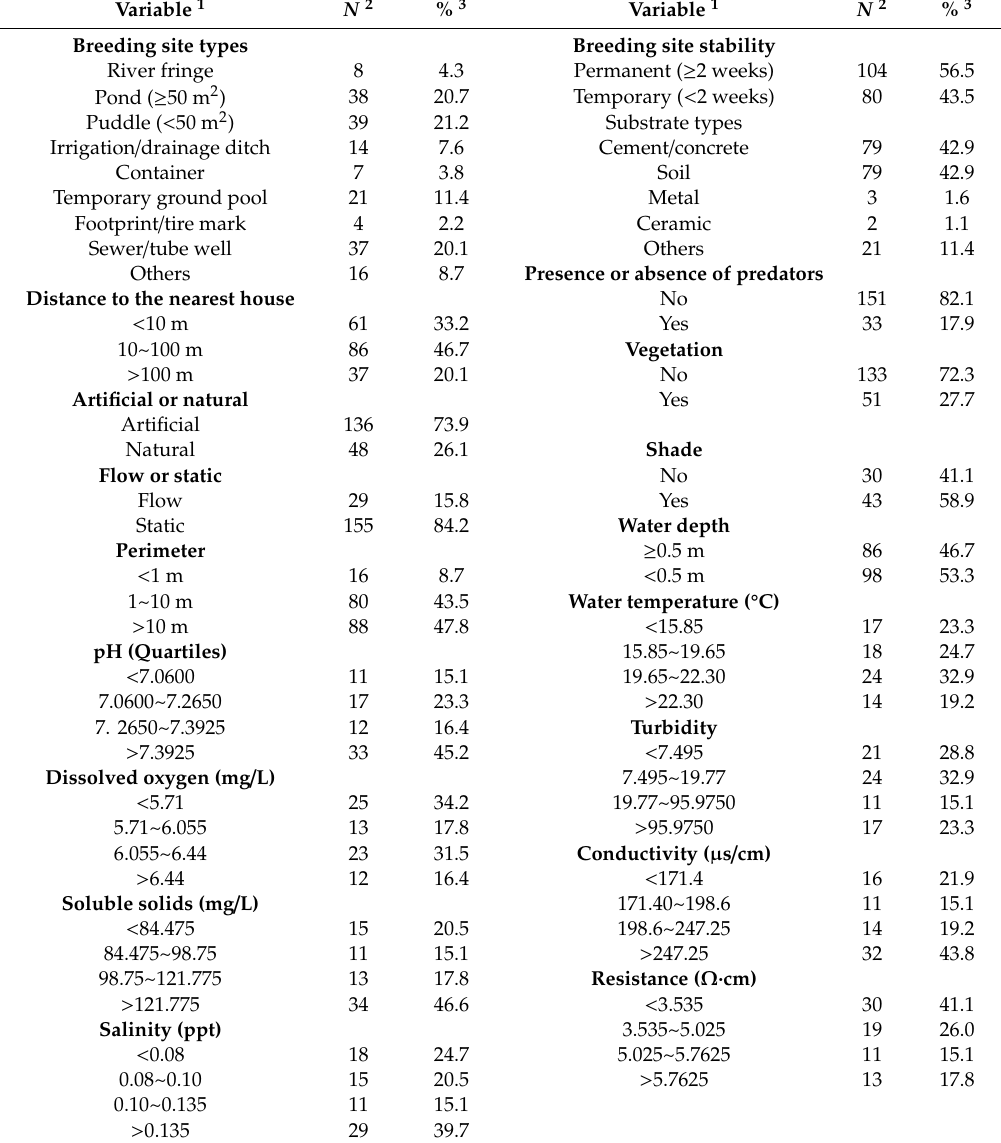
Table 2. The frequency and percent composition of the main characteristics of 184 potential mosquito breeding sites in Lhasa,